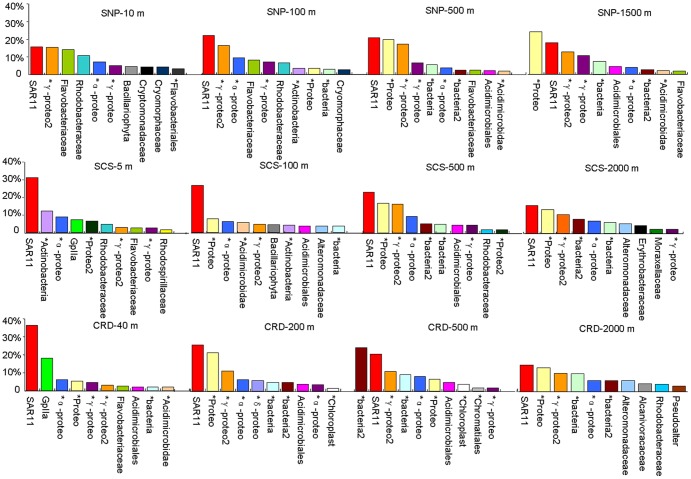
The 10 most abundant OTUs.Relative abundance and affiliation of the 10 most abundant OTUs on the family level for water samples collected from four different depths in subarctic North Pacific Ocean (SNP), tropical South China Sea (SCS) and Costa Rica Dome (CRD). *unclassified. Proteo represents Proteobacteria; Pseudoalter represents Pseudoalteromonadaceae.